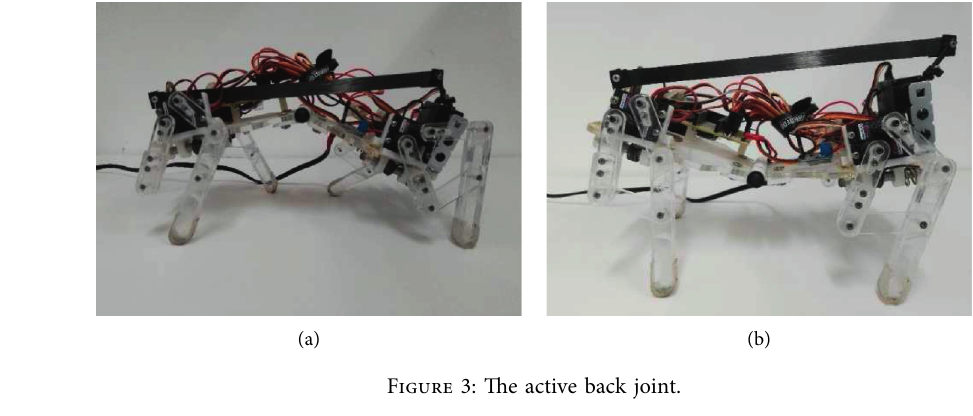
Figure 3: The active back joint.